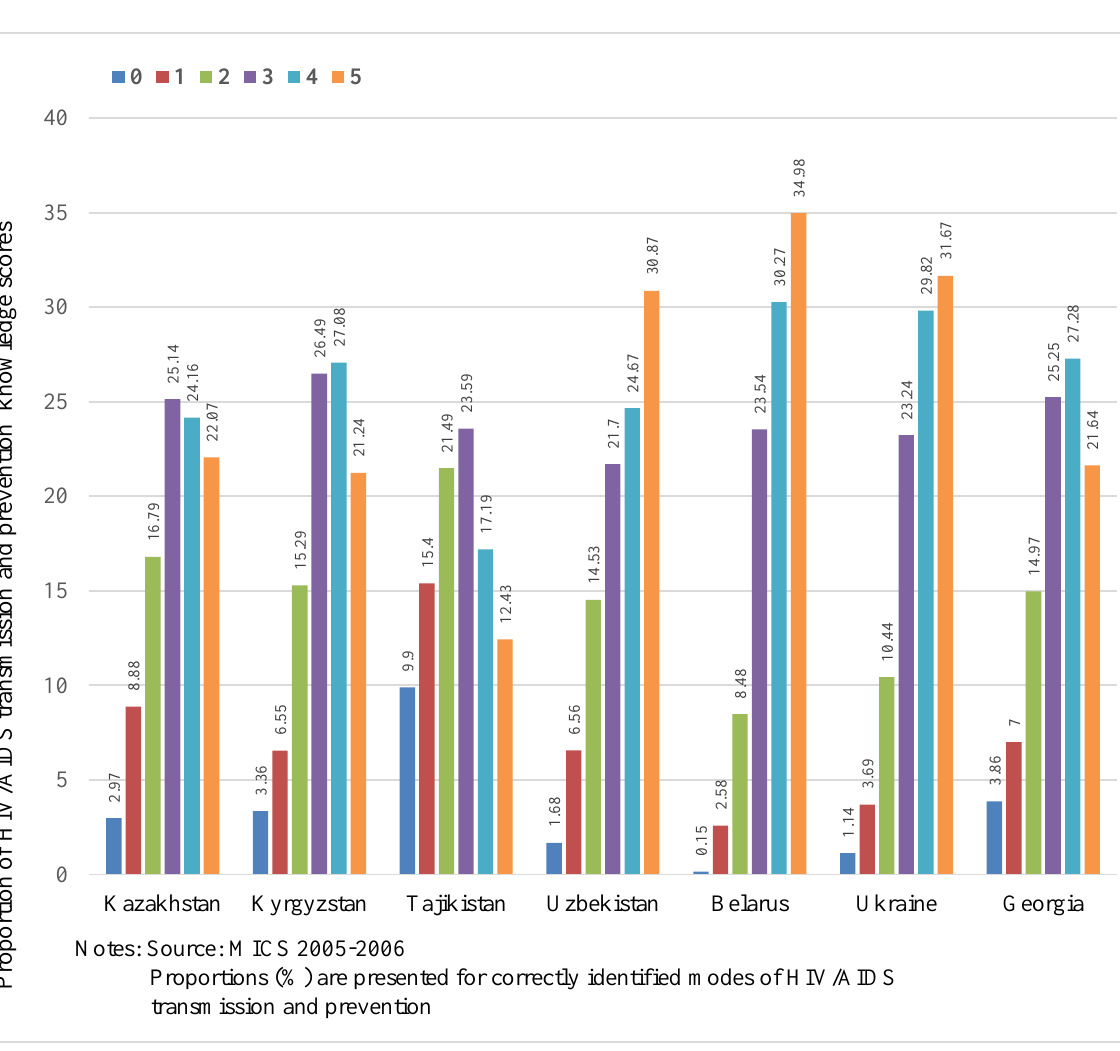
Respondents’ average comprehensive knowledge of HIV ranged from the lowest 2.60 (SD = 1.49) in Tajikistan to the highest 3.86 (SD = 1.08) in Belarus (Table 1). Average age ranged from 29.45 (SD = 9.97) in Uzbekistan to 32.31 (SD = 9.89) in Georgia. The majority of participants, ranging from 57.88% in Kazakhstan to 70.87% in Belarus, were currently married. A small percentage of respondents, ranging from 5.29% in Kazakhstan to 24.21% in Tajikistan, resided in the capital